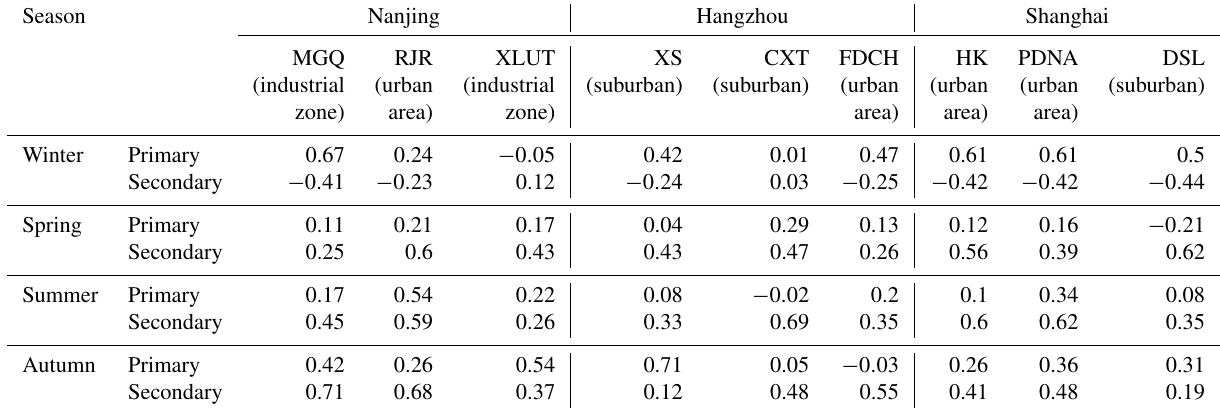
Table 4. The Pearson correlation coefficient ( R ) between the measured HCHO and primary HCHO emission and secondary HCHO formation in Nanjing, Hangzhou, and Shanghai in winter, spring, summer, and autumn. Line 1 in each season refers to primary HCHO and line 2 refers to secondary